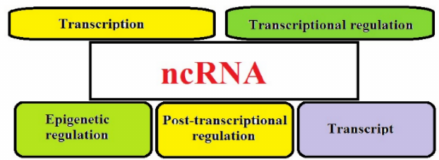
Figure 2. Gene regulatory mechanism of